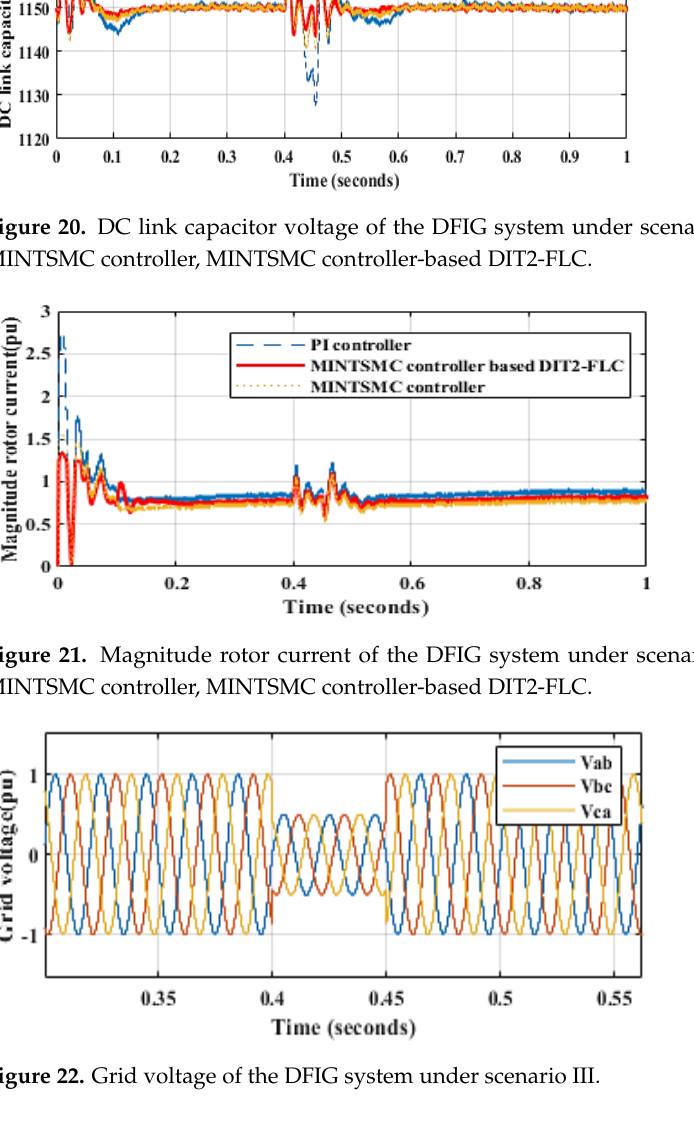
Figure 23. Grid current of the DFIG system under scenario III.